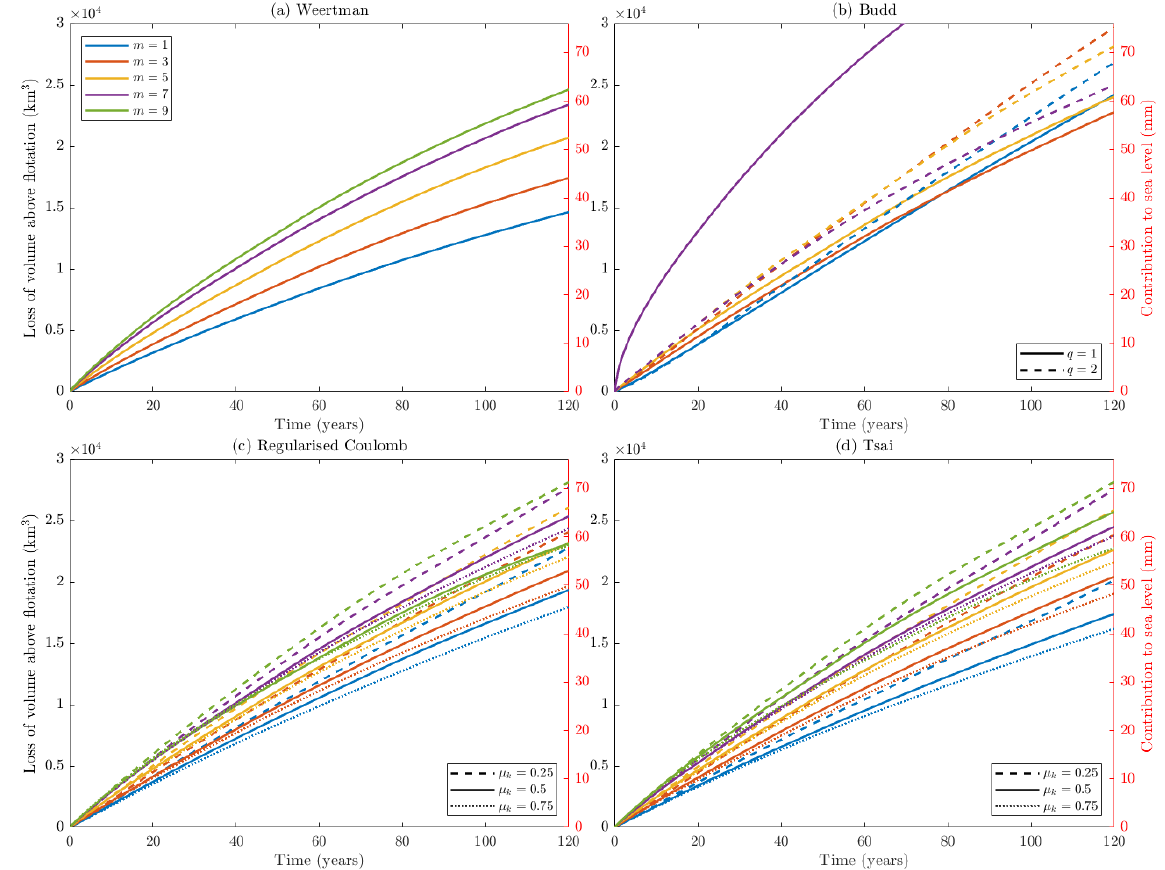
Figure 2. VAF loss in the control branch for every set of parameter choices in the sliding laws. Table 1. The VAF loss (mm sea level rise equivalent) at the end of the control branch simulations for all experiments. Values marked with an asterisk (*) indicate where a different prior had to be used in initialisation. Sliding law Value of m